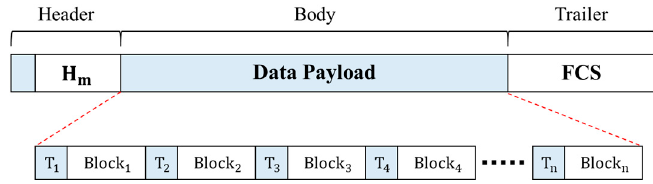
Figure 4. Structure of transmitted frame in DAM4SNC.